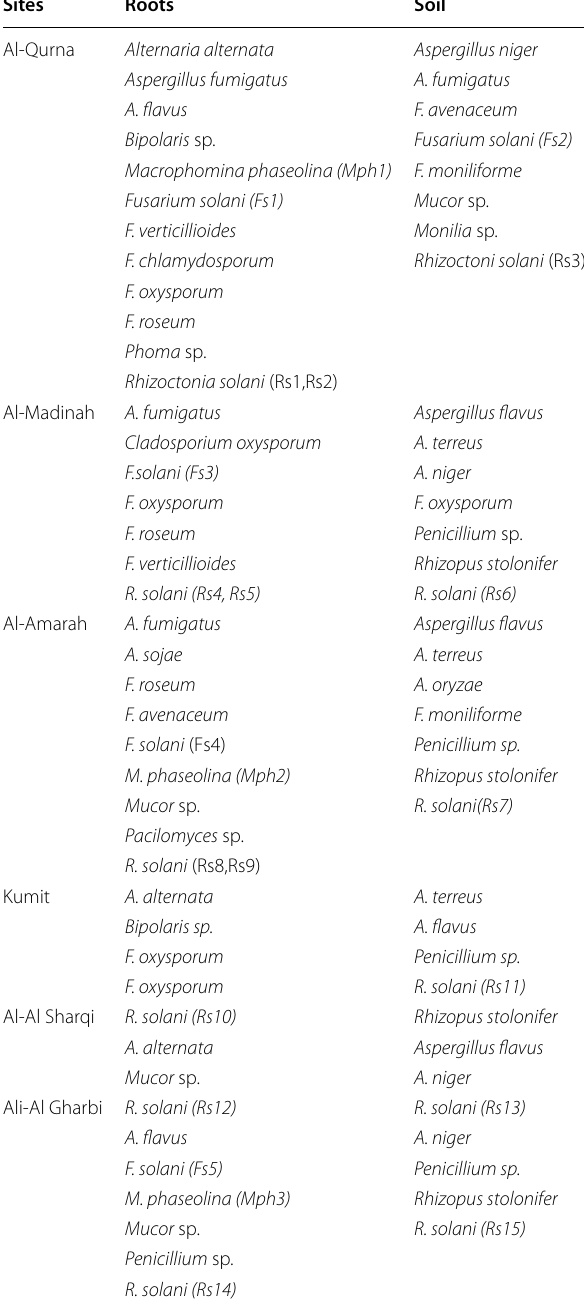
Table 2 Fungal isolates from different wheat